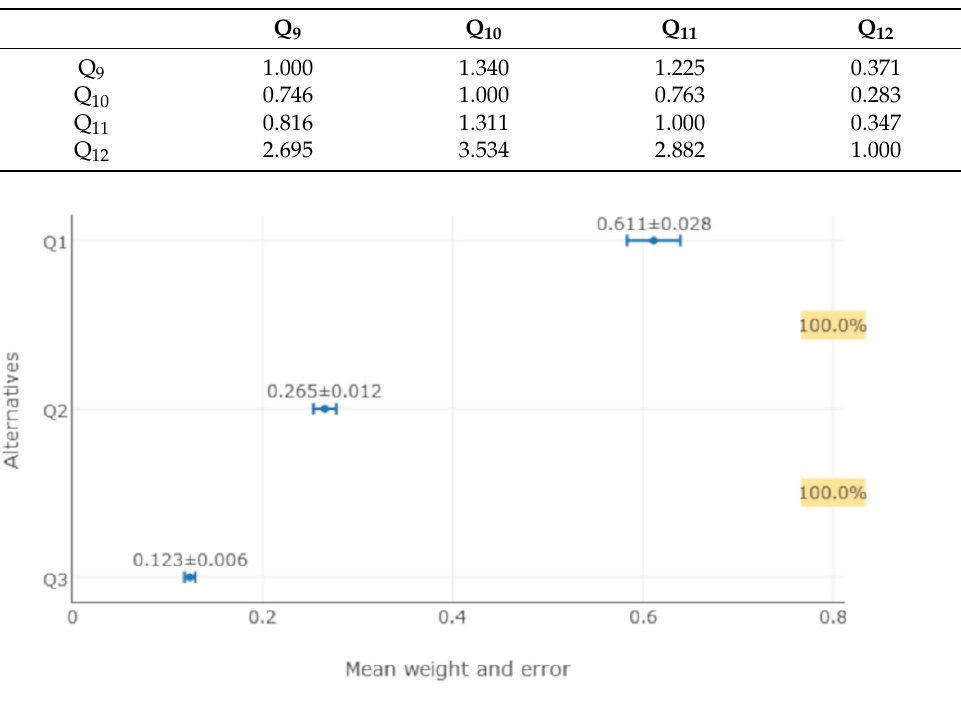
Figure 3. Alternatives (questions’ importance) comparison results with their mean weights, absolute errors, and ranking probabilities of compared alternatives Q4–Q8.